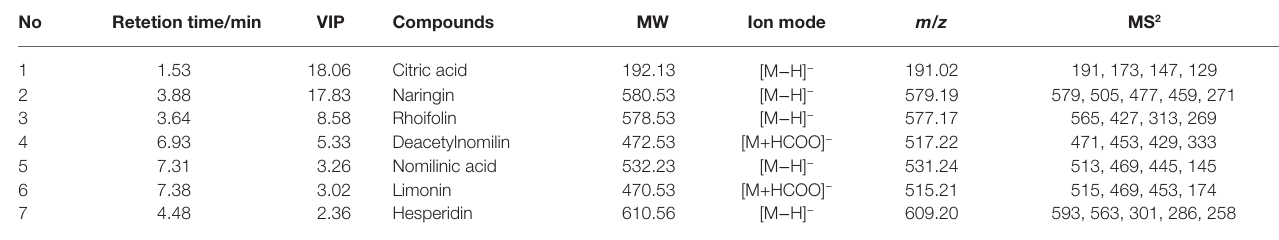
TABLE 2 | Differential metabolites identification of different drying